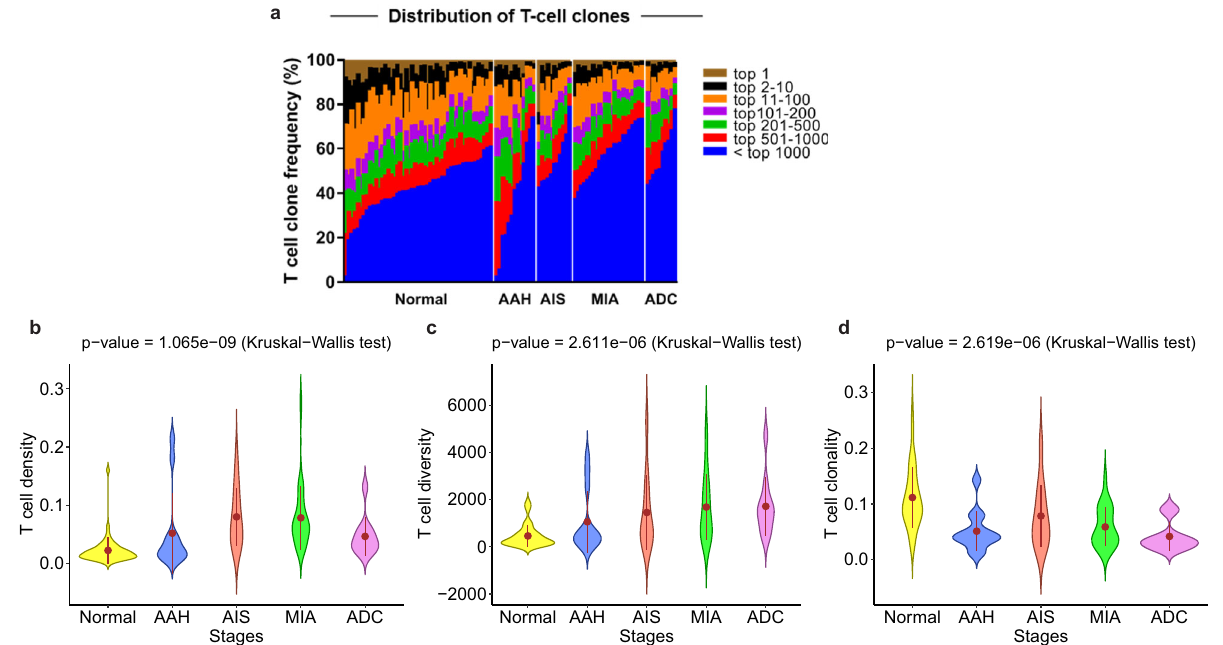
Fig. 3 T cell repertoire from preneoplasia to invasive lung adenocarcinoma. a Distribution of T cell clones with frequency of top 1 (brown), top 2 – 10 (black), top 11 – 100 (orange), top 101 – 200 (purple), top 201 – 500 (green), top 501 – 1000 (red), and beyond 1000 (blue) in normal lung, AAH, AIS, MIA, and invasive ADC lesions. b T cell density, c T cell diversity, and d T cell clonality in normal lung, AAH, AIS, MIA, and invasive ADC. Error bars indicate 95% con fi dence intervals and solid point represent mean value in each stage. The difference of T cell matrix among different stages was evaluated using two- sided Kruskal – Wallis H test. Data from 51 patients was used including NL (normal lung tissue), AAH (atypical adenomatous hyperplasia), AIS (adenocarcinoma in situ), MIA (minimally invasive adenocarcinoma), and ADC (invasive adenocarcinoma). (Source data is provided as a source data fi le).